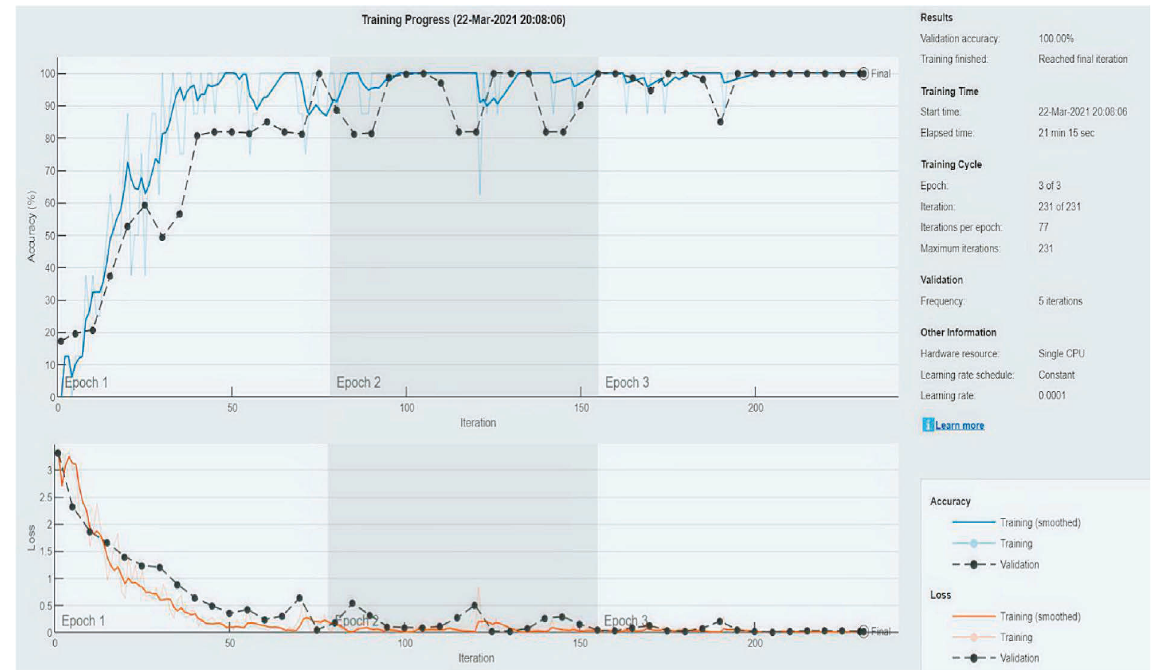
Figure 7: Training progress of finely tuned SqueezeNet.